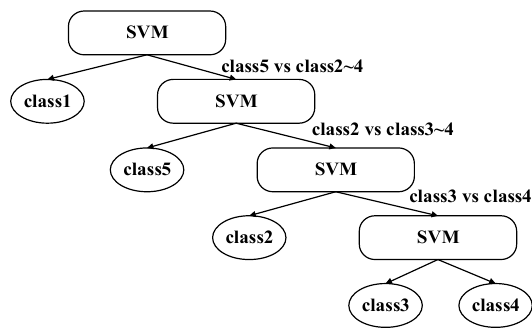
Figure 8. Hierarchical structure of decision tree support vector machine (DT-SVM) multi-classifier.